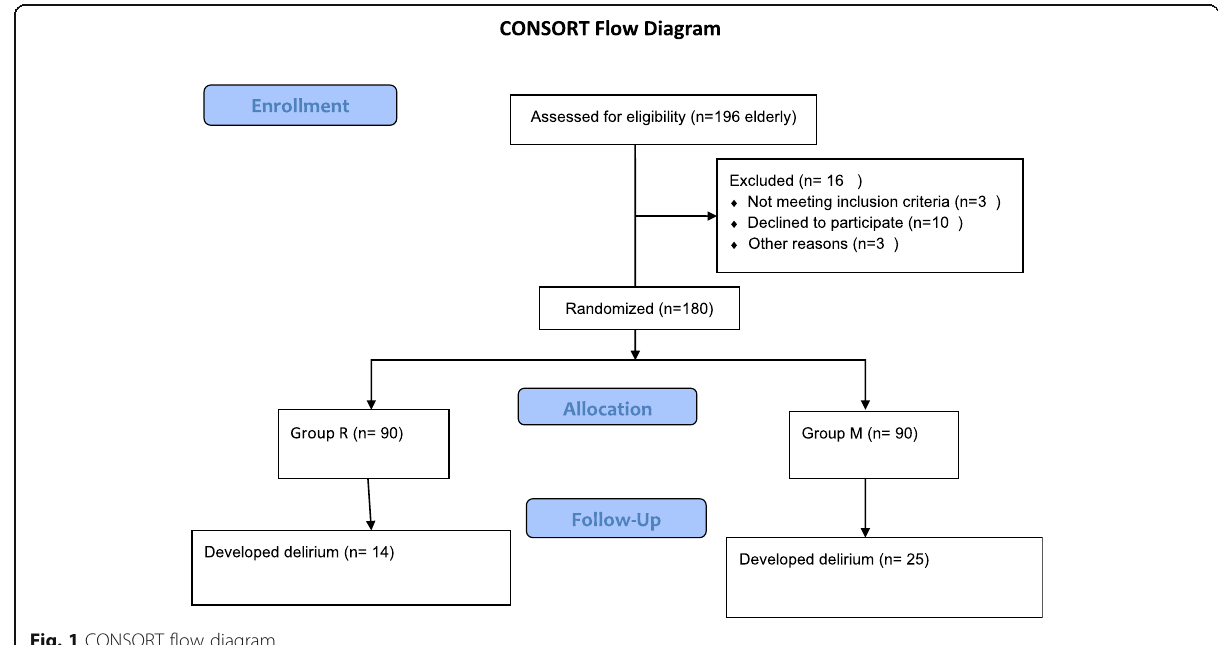
Fig. 1 CONSORT flow